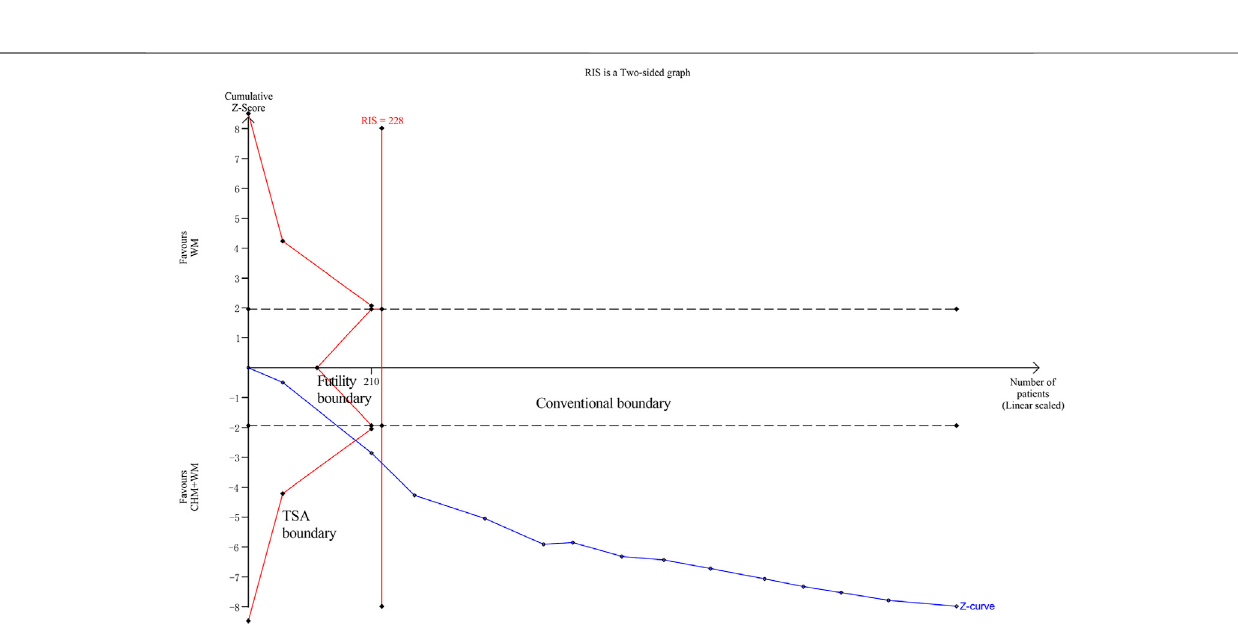
Frontiers in Pharmacology | www.frontiersin.org June 2021 | Volume 12 | Article 678631